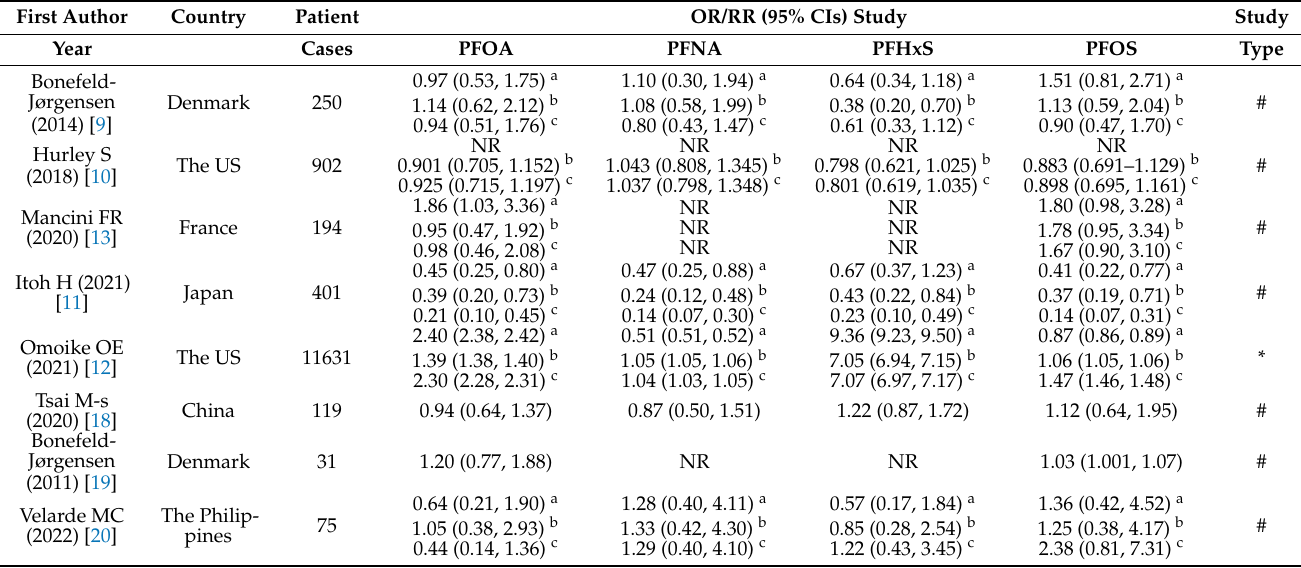
Table 1. Characteristics of studies entered in the